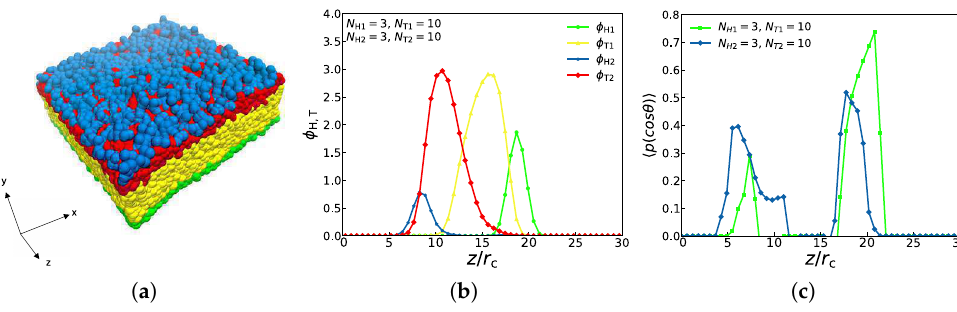
Figure 3. A snapshot for the lipid bilayer ( a ) is shown at the top. The density profiles ( b ) of head and tail particles and the order parameters ( c ) are shown along the z axes in the middle and bottom,